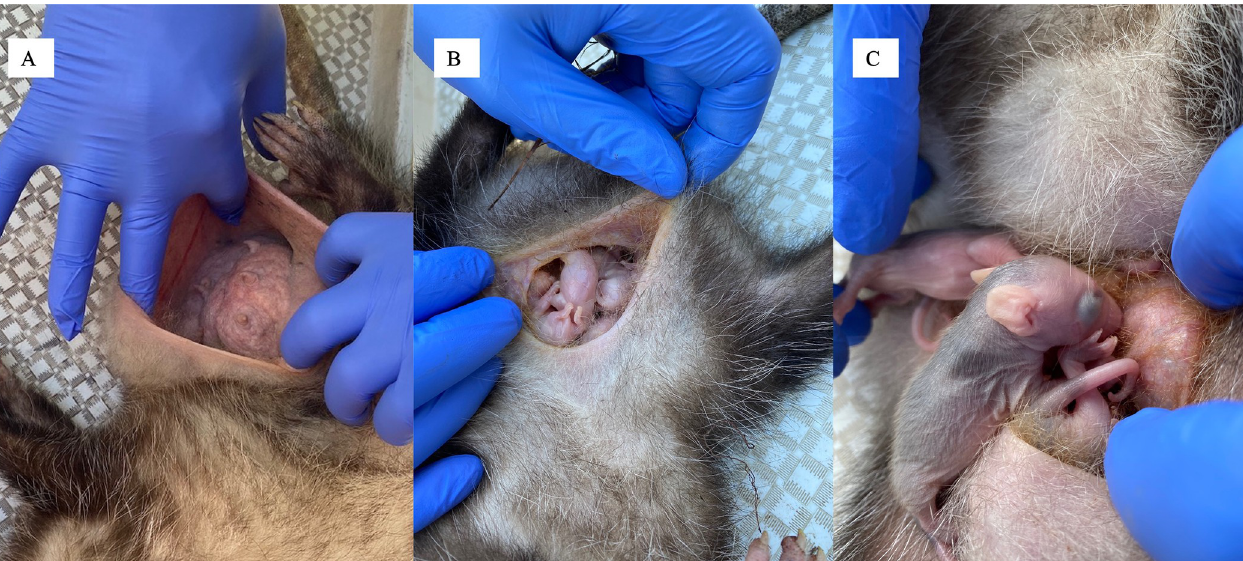
Fig 3. Female Virginia opossum and joeys. A depiction of the marsupium from two adult female Virginia opossums. From the first female, her marsupium, which is expanded to show that it does not contain joeys, and to further detail the cleanliness of the feature and the expanse of the pouch that holds the joeys within (A). From a second female her marsupium gently expanded to expose the mother-dependent joeys held within (B), and from a third female, a mother- dependent joeys with its categorically important features: developing hair, ears, eye openings, while still attached to the mother’s teat (C) (Photo credit: C.W.